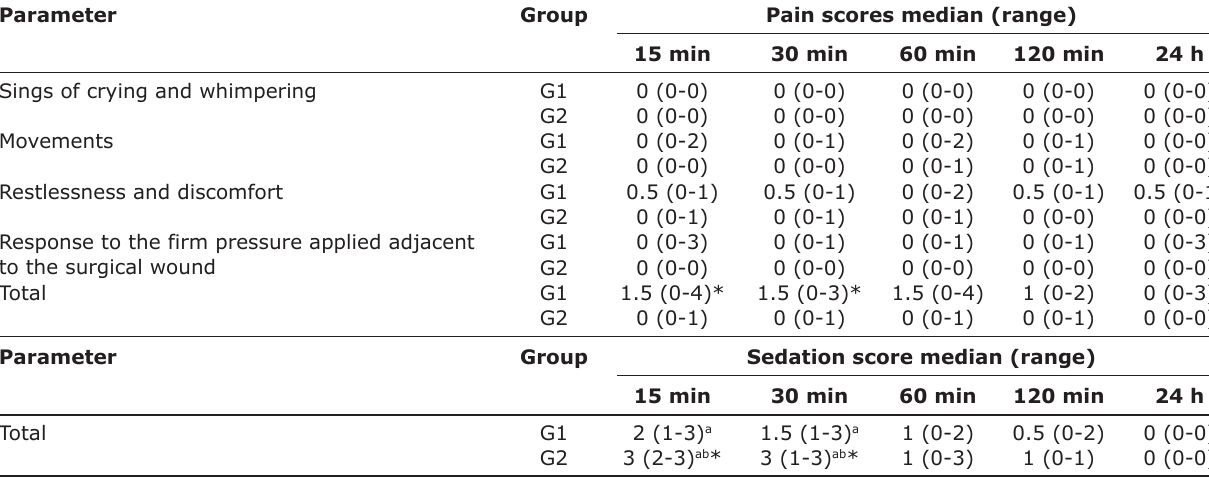
Table-2: Pain and sedation score presented as median (range) at each of the assessment points in G1 and G2. Parameter Group Pain scores median (range)